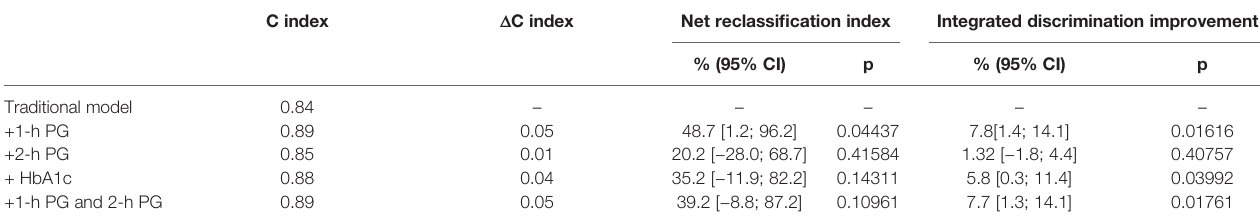
TABLE 3 | Prognostic performance of 1-h PG levels for hyperglycemia relapse.